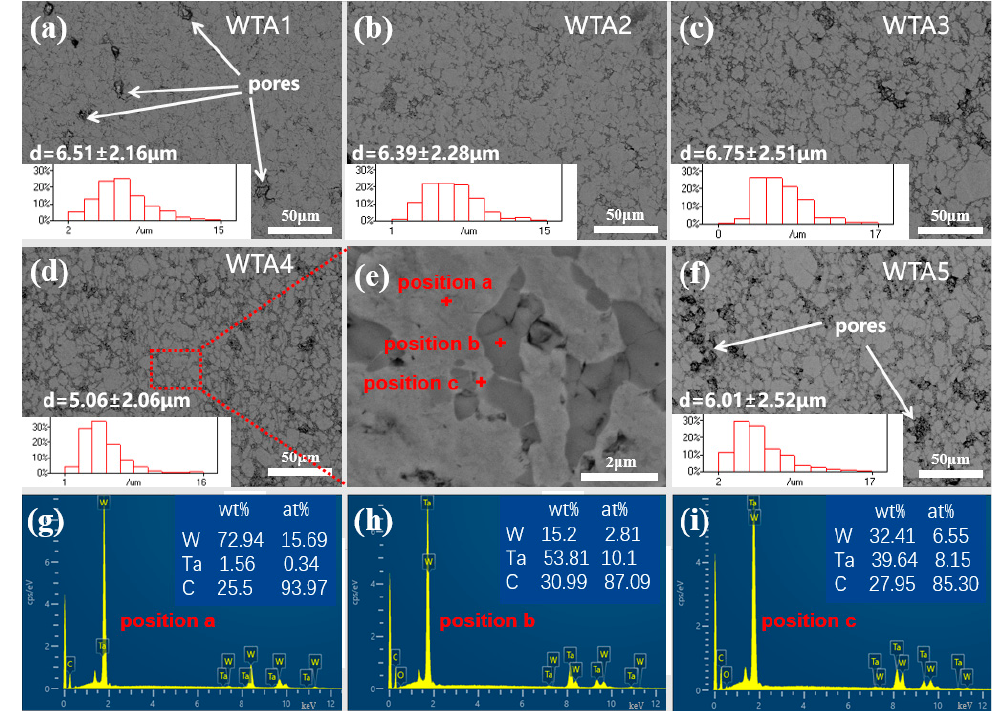
Figure 2. Backscattered electron images of WTA1–WTA5 composites and corresponding EDS results of specific locations in the composite WTA4.